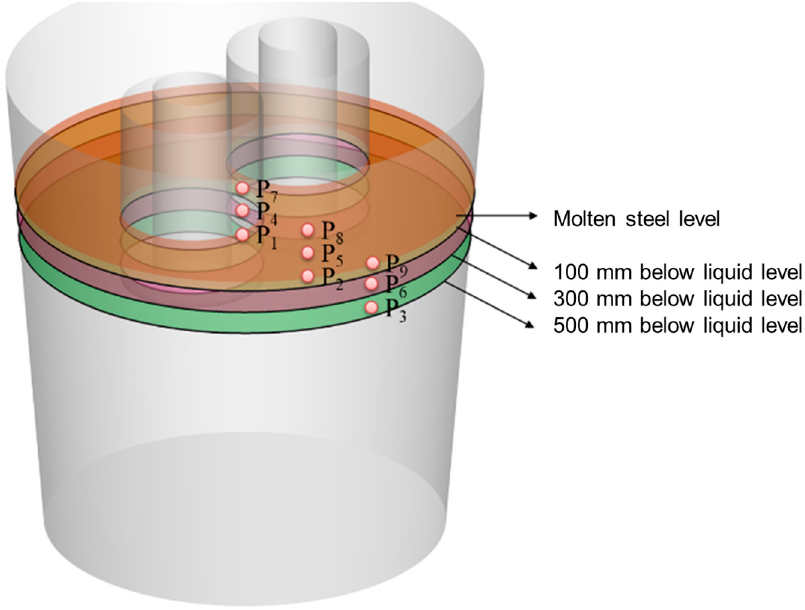
Figure 5. Positions of nine monitors.